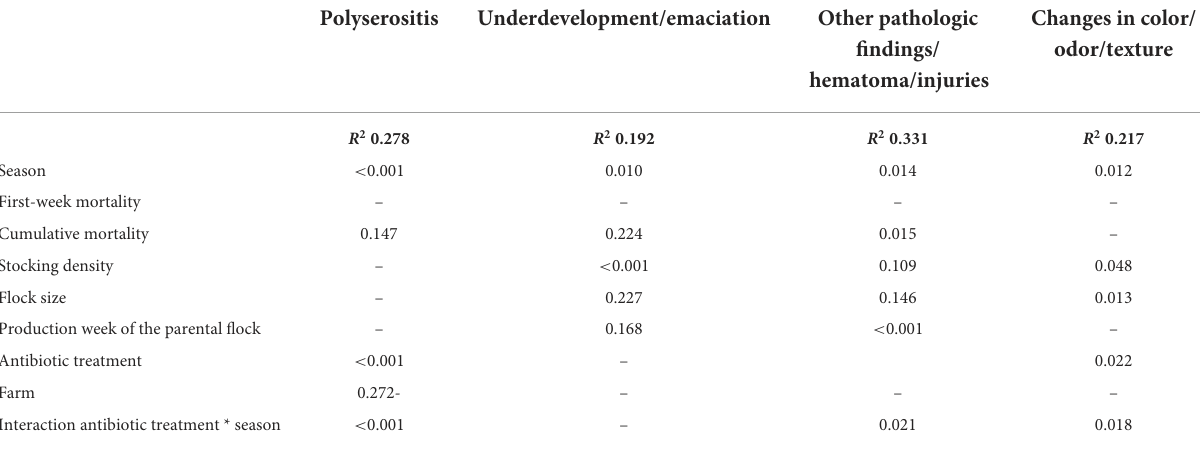
TABLE 5 P -values of the multifactorial analysis using a generalized linear model for the dependent variables polyserositis, underdevelopment/emaciation, other pathologic findings/hematoma/injuries and changes in